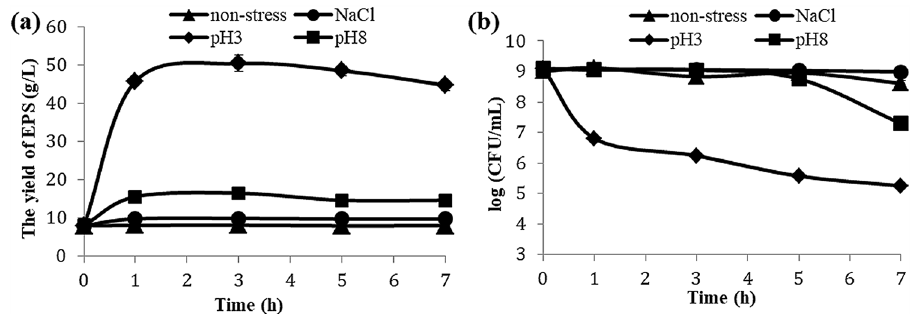
Figure 1. The EPS yield ( a ) and cell density ( b ) of L. plantarum VAL6 under pH and sodium chloride stresses. The non-stress control was maintained at 37 °C, pH 6.8 and without sodium chloride for the entire time. Standard deviation is displayed and account for three independent